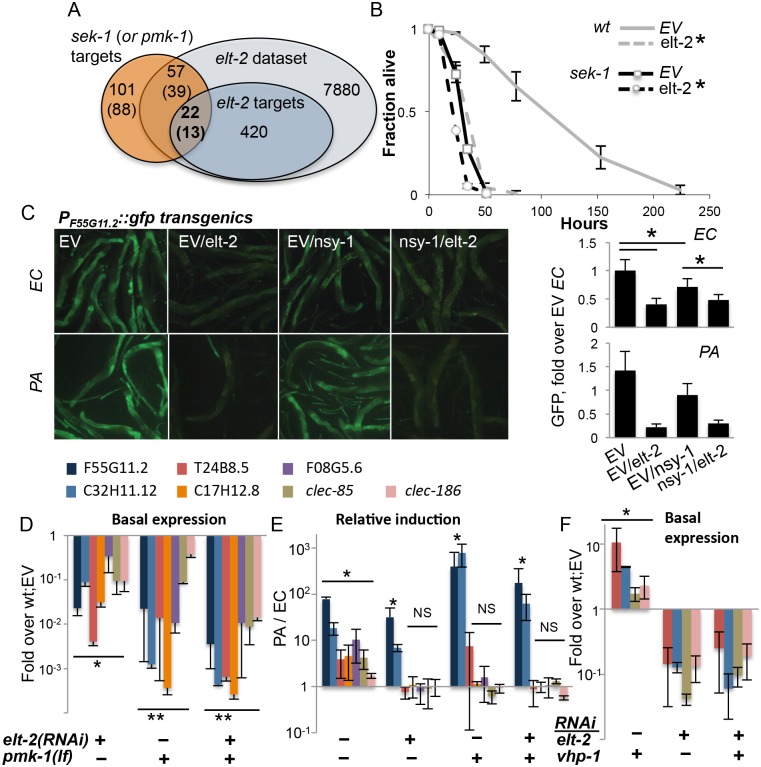

elt-2 and the p38 pathway co-regulate immune protection.
A. Overlaps between sek-1 (or pmk-1) targets (Troemel et al., 2006), and elt-2 targets; gene numbers are shown. B, Survival curves for wildtype and sek-1 animals fed with designated RNAi’s during early adulthood, followed by P. aeruginosa infection; averages ± SDs for three plates (N = 92–151 per group,*p<0.0001 (Logrank test)); shown is a representative of several experiments with similar results. C, P
F55G11.2::gfp worms fed with RNAi as designated during adulthood and exposed to P. aeruginosa (PA, 4 hours, N = 10–19 per group) or E. coli (EC, N = 19–25); signal quantification shown on the right, *p<3xE-6, ttest. Shown is a representative experiment of two with similar results. D-F, Gene expression in wildtype or pmk-1(km25) loss-of-function animals fed with designated RNAi’s during larval development. Shown are averages and SDs for two independent experiments D,F, basal expression (values and statistics relative to values in wt;EV (set to 1 and therefore not shown). E, Induction following 12 hours of P. aeruginosa infection, relative to basal expression in similarly-treated worms grown on E. coli. *p<0.01, **p<0.0005 (paired t-test); asterisks mark significant differences for individual gene(s), or for each of the genes in a group designated by a line.